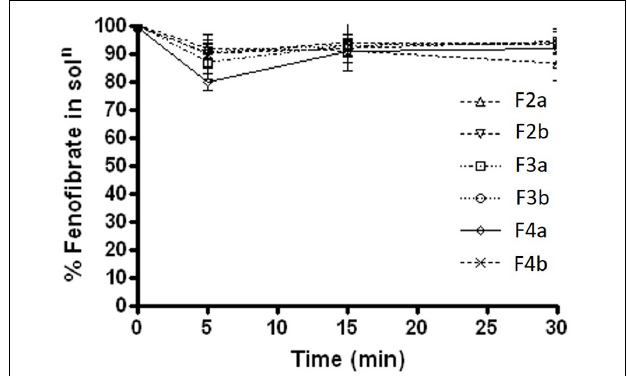
FIGURE 5 | The % fenofibrate in solution during 24 h time after 1:100 dilution in the simulated fed state intestinal media (fenofibrate was dissolved at 80% of the equilibrium solubility in the anhydrous mixture). The formulation represent F2a- C70: CM (7:3)/TO106V (1/1), F3a- C70: CM (7:3)/ HCO-30 (1/1), F2b- K70:I742(7:3)/TO106V(1/1), F3b- K70:I742(7:3)/HCO-30 (1/1), F4a- CMCM/HCO-30 (1/1), and F4b- I742/HCO-30 (1/1) respectively. Data are presented as mean ± SD, ( n = 3).